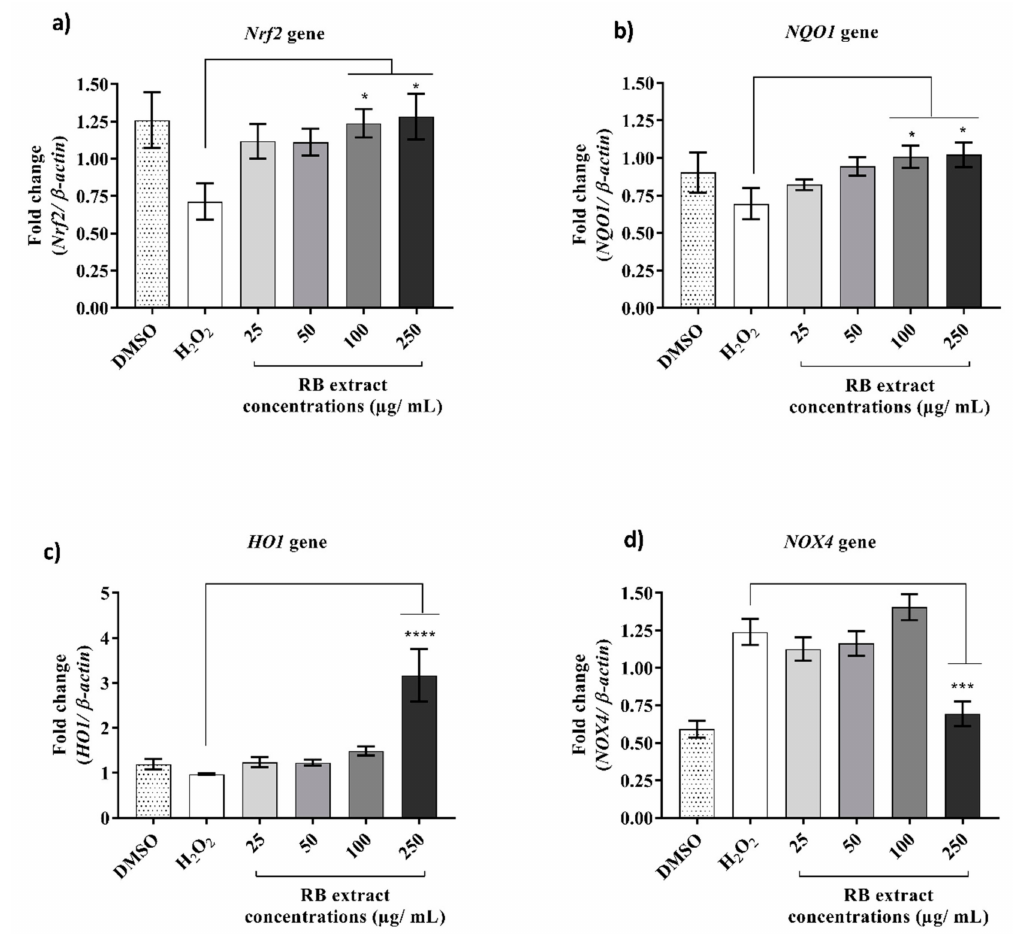
Figure 2. E ff ect of RB phenolic extracts on antioxidant genes. ( a ) Nrf2 ( b ) NQO1 ( c ) HO1 ( d ) NOX4 in HUVECs under oxidative stress conditions. A significant increase ( p < 0.05) in the expression of Nrf2 and NQO1 genes was observed with pre-treatment at 100 and 250 µ g / mL of RB phenolic extracts when compared to the H 2 O 2 only treated group. The expression of HO1 gene was significantly increased when pre-treated with 250 µ g / mL of RB phenolic extracts. In the NOX4 gene, a significant reduction in expression ( p < 0.001) was observed at the highest RB phenolic concentration of 250 µ g / mL. The level of significance is indicated by the asterisks, whereby * p < 0.05, *** p < 0.001, **** p < 0.0001. n = 3. Data is presented as mean ± SEM. Dimethyl sulfoxide, DMSO; hydrogen peroxide, H 2 O 2 ; human umbilical vein endothelial cells, HUVEC; rice bran, RB; nuclear factor erythroid 2-related factor 2 ( Nrf2 ); NADPH: quinone oxidoreductase 1 ( NQO1 ); heme oxygenase 1 ( HO1 ); NADPH oxidase 4 ( NOX4 ). 2.3. E ff ect of RB Phenolic Extracts on Anti-Inflammatory Genes under Oxidative Stress